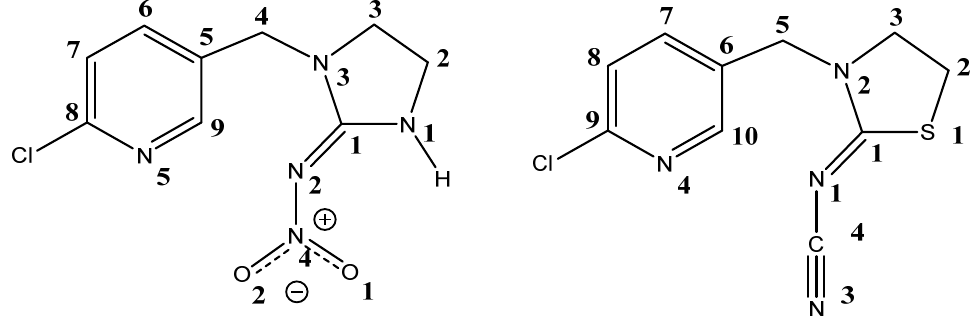
Figure 1. Chemical structures of the neonicotinoids, imidacloprid ( left ) and thiacloprid ( right ).